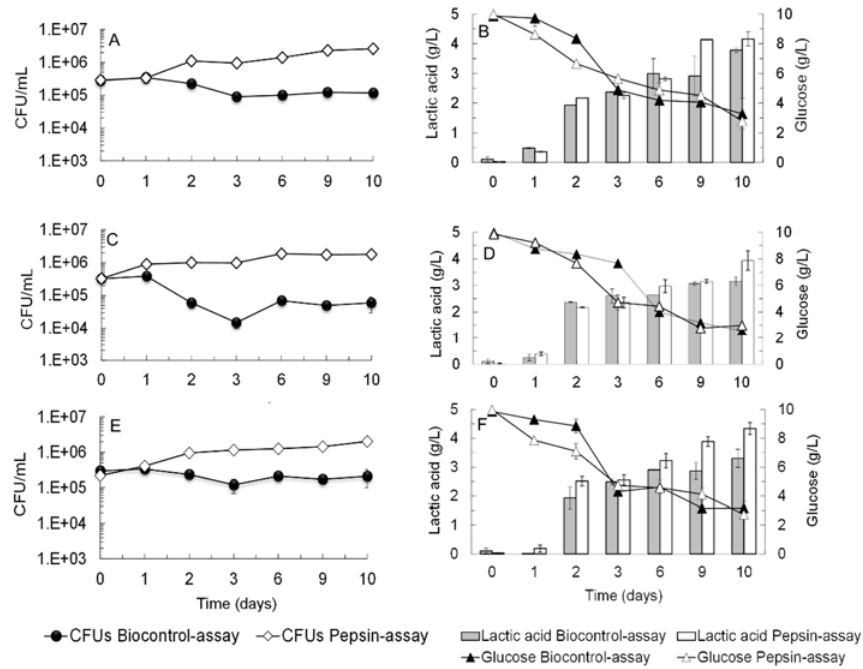
Figure 5. Culturability ( A , C , D ), glucose consumption and lactic acid production ( B , D , F ) during growth assays performed with L. mesenteroides subsp. cremoris ( A , B ), P. parvulus ( C , D ) and P. pentosaceus ( E , F ) inoculated in a cell-free supernatant pre-fermented by S. cerevisiae ER without any treatment (biocontrol assay) and after a pepsin treatment (pepsin assay). Data represented correspond to means ± SD (error bars) of two independent biological assays.